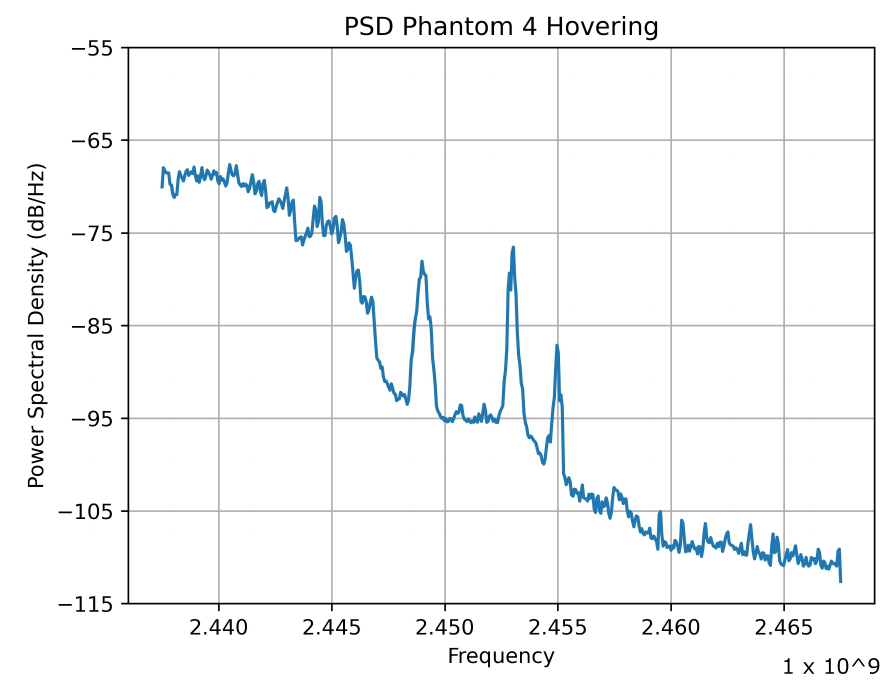
Figure 7. PSD: Phantom 4 hovering.